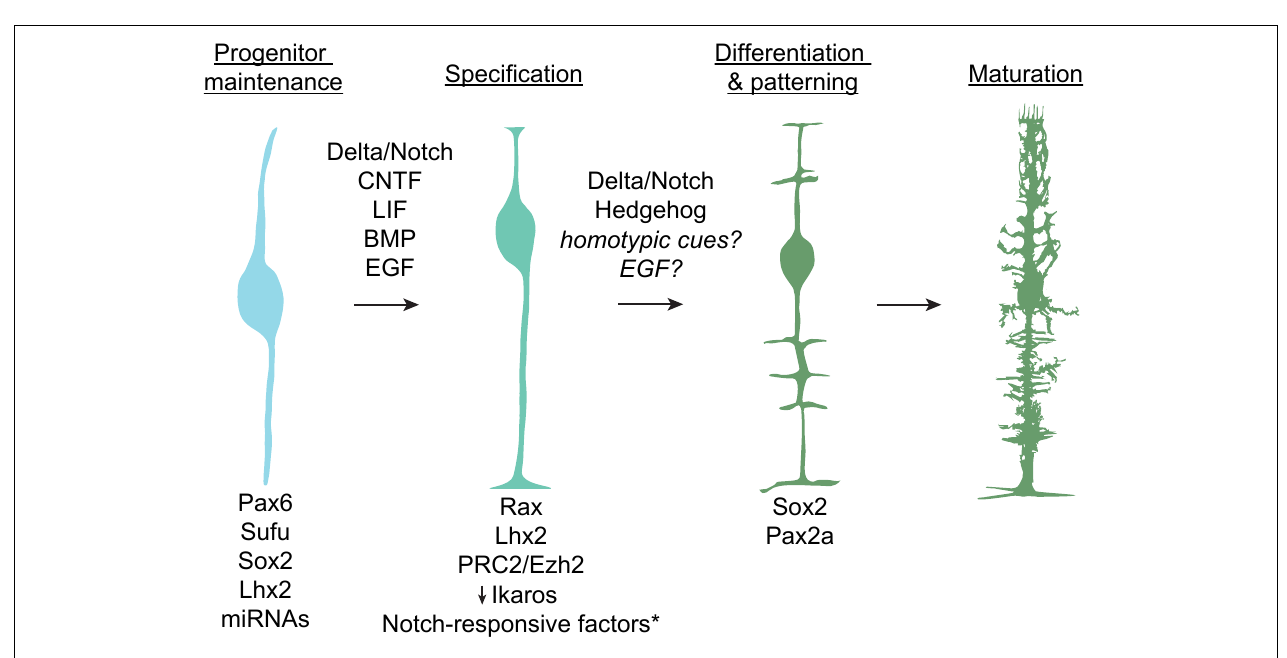
FIGURE 2 | Known factors underlying the progression from retinal progenitors to mature Müller glia. Cell intrinsic molecules including transcription factors and microRNAs which mediate maintenance of cell identity or differentiation at each step are listed at bottom. Contact-dependent (Delta/Notch) and growth factor signaling pathways thought to promote Müller glial specification and differentiation are listed above arrows. *Notch-responsive factors include Hes1, Hes5, Hesr2, Id1-3, Sox9, and Nfia/b/x.